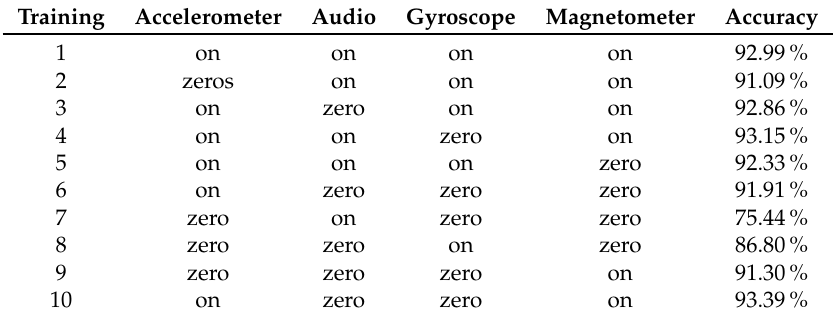
Table 3. Mean accuracy of the neural network with various input settings with five